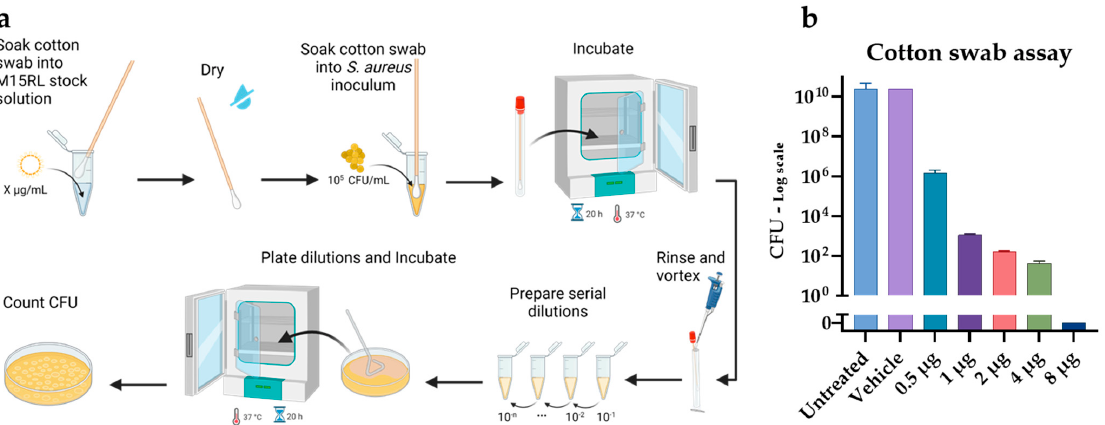
Figure 8. Experimental design of the cotton swab assay ( a ), created with BioRender.com. M15RL- soaked swabs exhibited high antimicrobial activity ( b ).